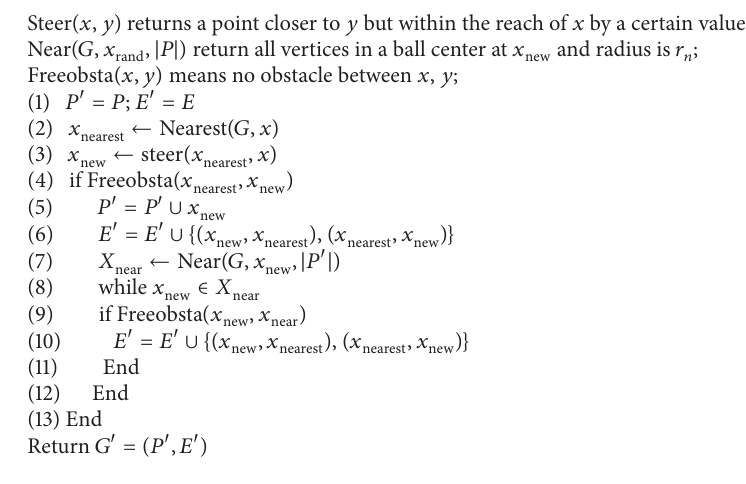
Algorithm 2: Explore RRG ( 𝐺, 𝑥 ).